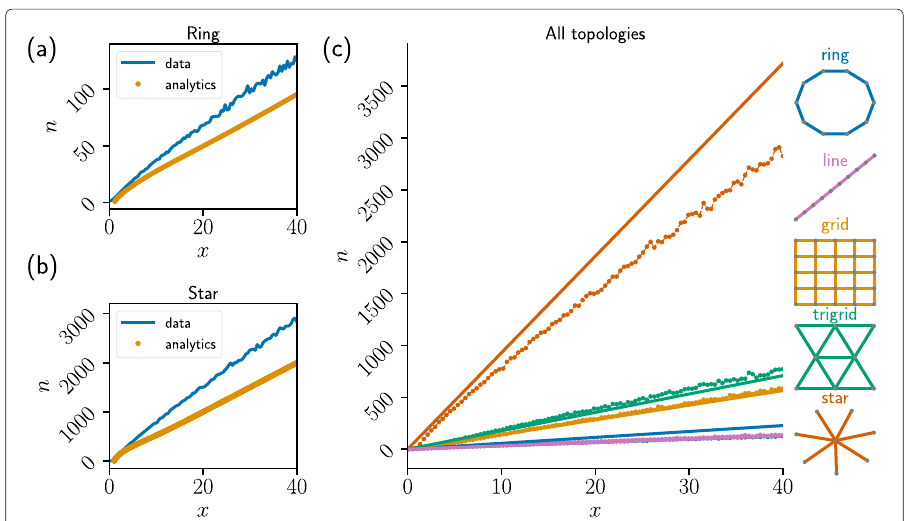
Fig. 4 Scaling of stop-list length n vs. (dimensionless) request rate x . In the limit for large x , n scales approximately linearly with x for all networks. The slope grows with the dimensionality of the street network. a 100 node ring, n measured directly (blue line) qualitatively agrees with n reconstructed from volumes using Eq. 9 b 100 node star, n measured directly (blue line) qualitatively agrees with n reconstructed from volumes using Eq. 10 c simulated n vs. x for ring, line, grid, triangular grid and star, measured directly (dots) agrees with n reconstructed from measured (cid:2) V (cid:3) rest (line) according to Eq.